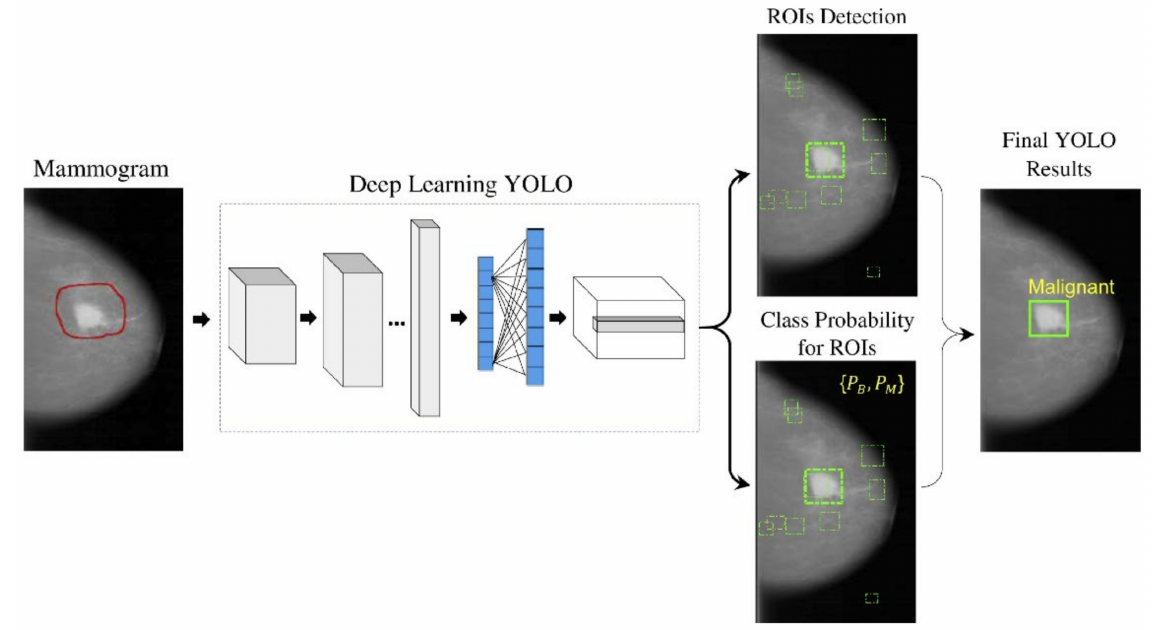
Figure 7. Schematic diagram of the proposed YOLO-based CAD system in [131]. Reprinted/adapted with permission from [131]. 2021,